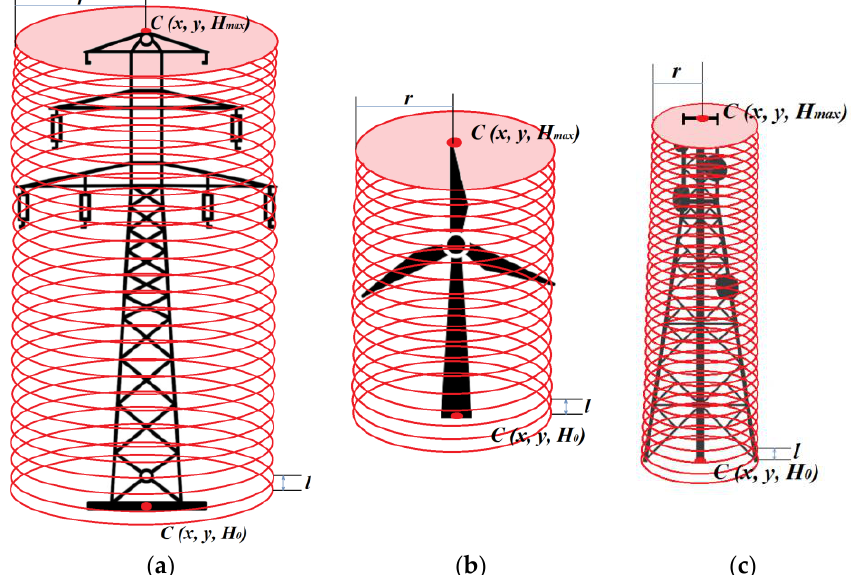
Figure 4. Determination of the height of the detected obstacle: ( a ) energy pole, ( b ) wind turbine, ( c ) mast.